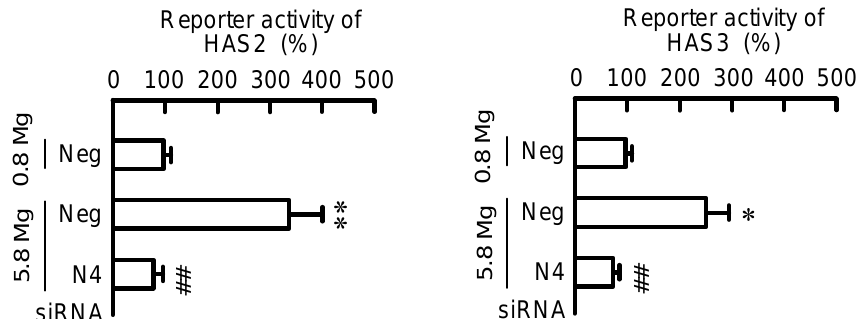
Figure 4. Effects of extracellular Mg 2+ concentration and NIPAL4 siRNA on reporter activities of HAS2/3. Cells were transfected with negative (Neg) or NIAPL4 (N4) siRNA. After 66 h of transfection, the cells were incubated in the presence of 0.8 and 5.8 mM MgCl 2 for 6 h. The activities of secreted luciferase and SEAP were measured using a Ready-To-Glow Dual Secreted Reporter Assay kit. The reporter activity is represented as a percentage of 0.8 mM MgCl 2 . n = 4. ** p < 0.01 and * p < 0.05 significantly different from 0.8 mM MgCl 2 . ## p < 0.01 significantly different from negative siRNA plus 5.8 mM MgCl 2 .